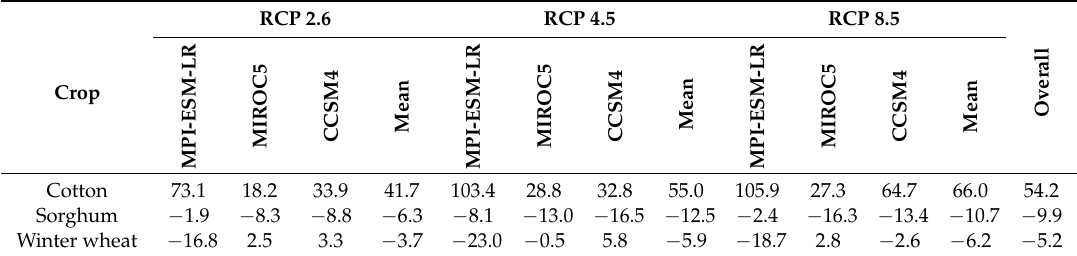
Table 6. Percentage crop yield changes under the modeled climate change scenarios relative to the historical yield. The values represent the difference between the calculated average crop yield for the climate scenario and the observed average yield expressed as a percent of the observed